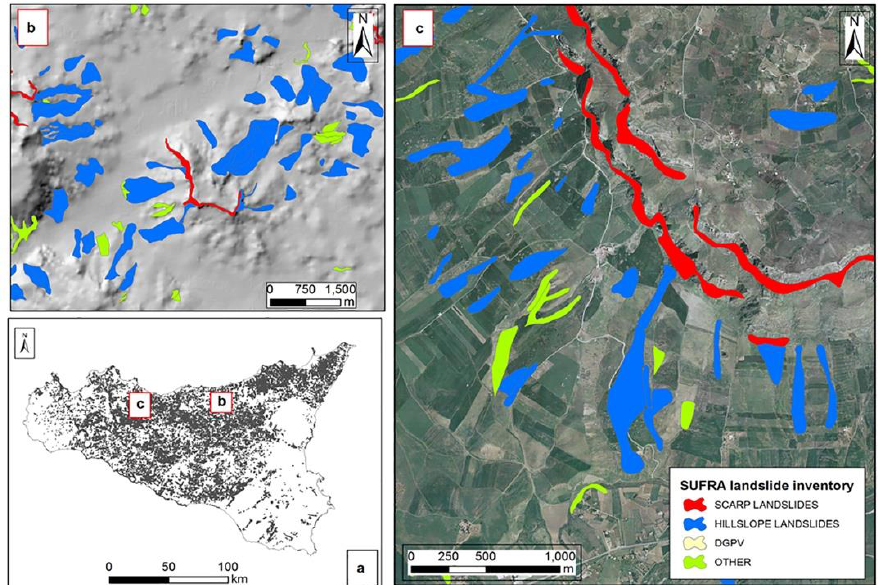
Figure 2. PAI landslide inventory. ( a ) Regional distribution of landslides; ( b ) detail of a portion of the territory of landslides on the hillshade grid; ( c ) PAI landslides on orthophotos.